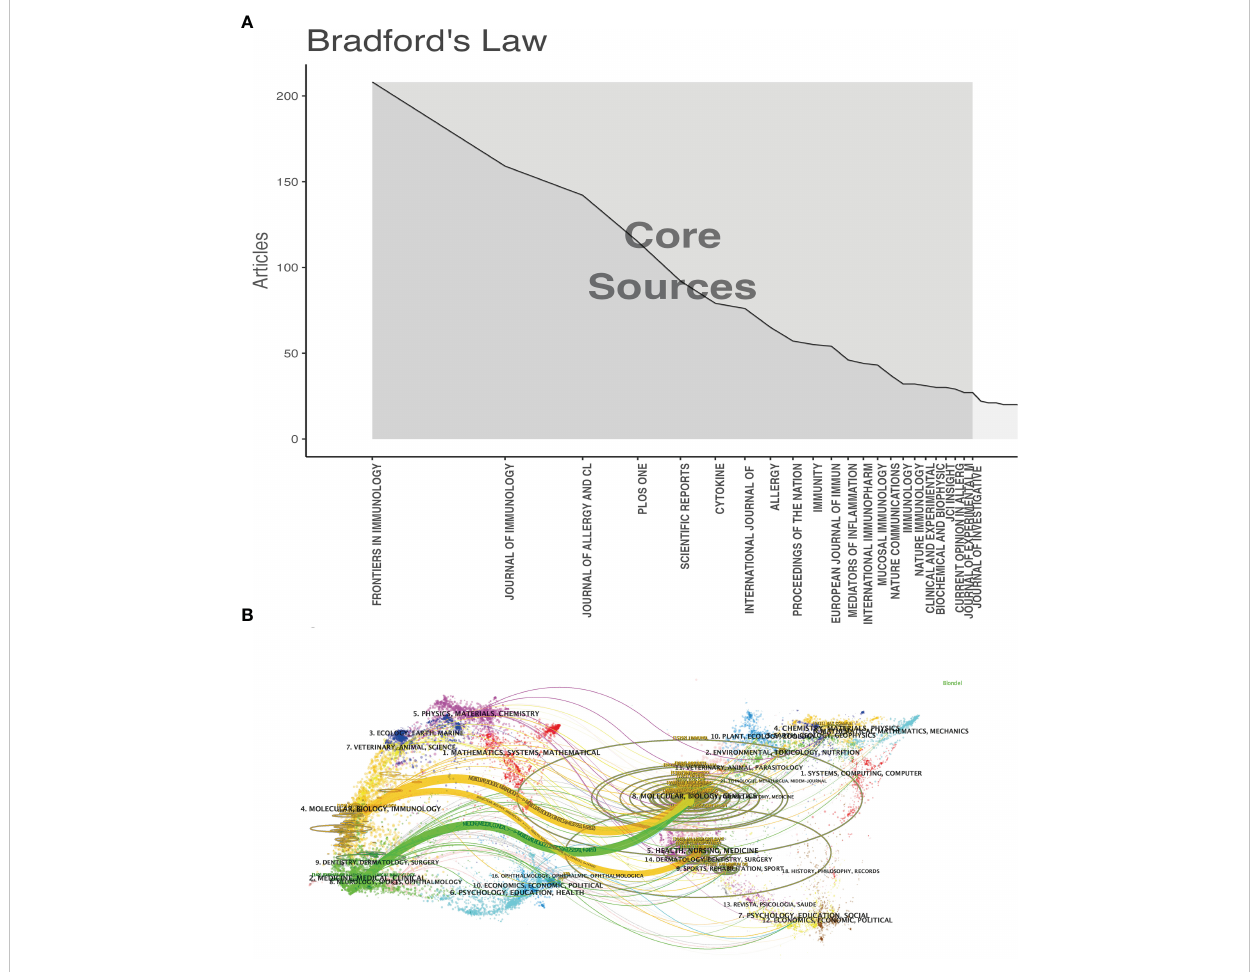
FIGURE 4 The analysis of academic journals related to IL-33. (A) Bradford ’ s Law according to the academic journals. (B) A dual-map overlay of the journals on IL-33 research. Clusters of citing journals are on the left, cited journals are on the right, and colored trails between them indicate the cited relationships.